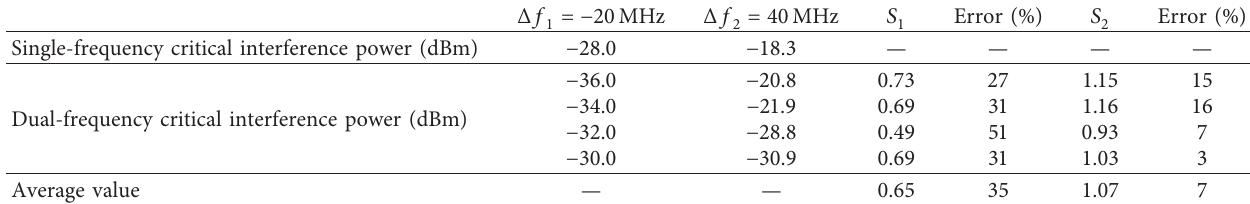
Table 1: Critical interference power when the frequency offset of interference signal is − 20 MHz and 40MHz.